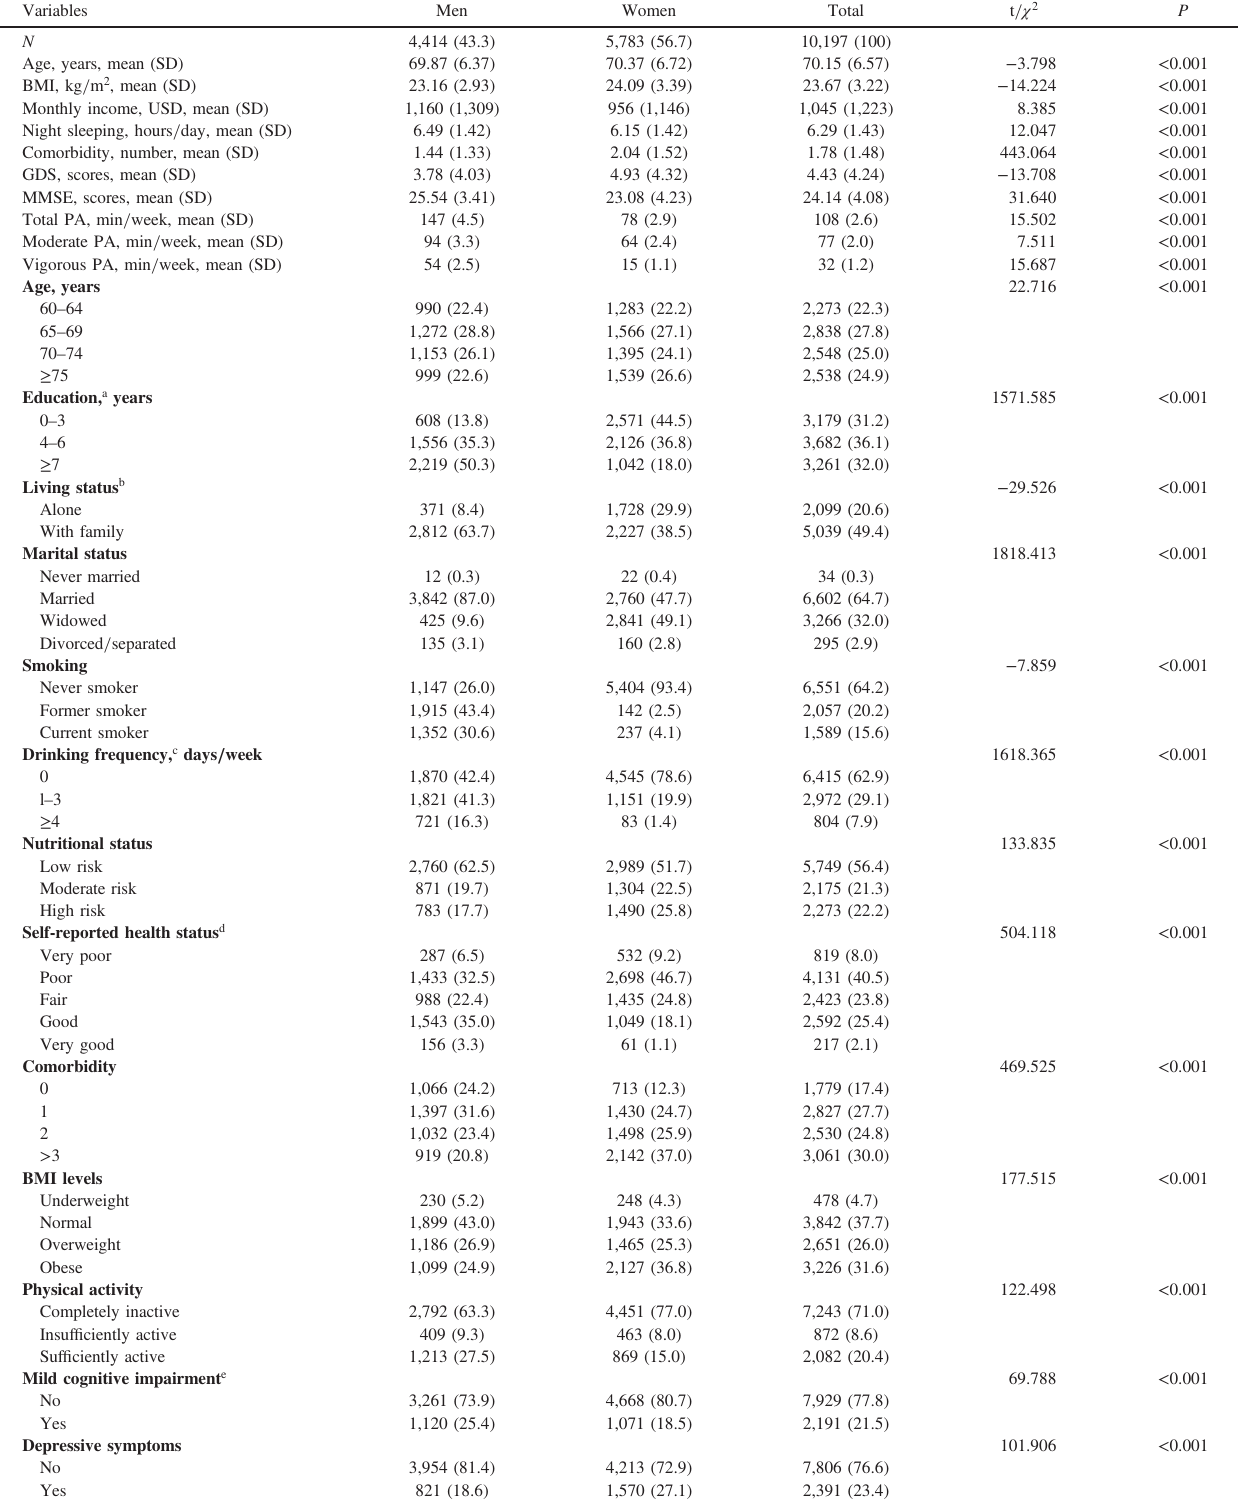
Table 1. Baseline characteristics of full study samples